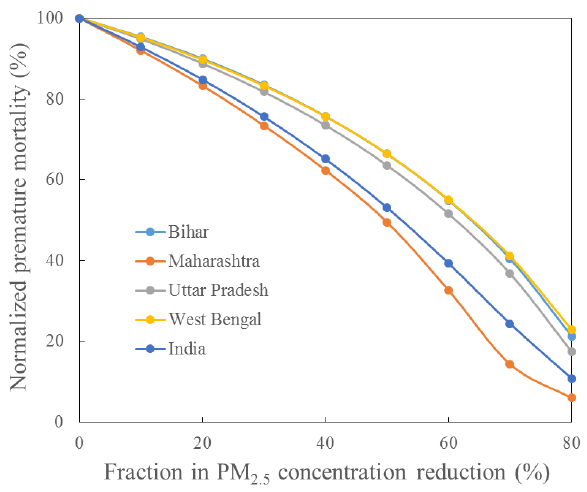
Figure 6. Premature mortality (normalized to 2015 deaths) as a function of the fractional reduction in PM 2 . 5 concentrations (rel- ative to 2015 concentrations) for the whole of India and the top PM 2 . 5 polluted states, Bihar, Maharashtra, Uttar Pradesh (includ- ing Delhi), and West